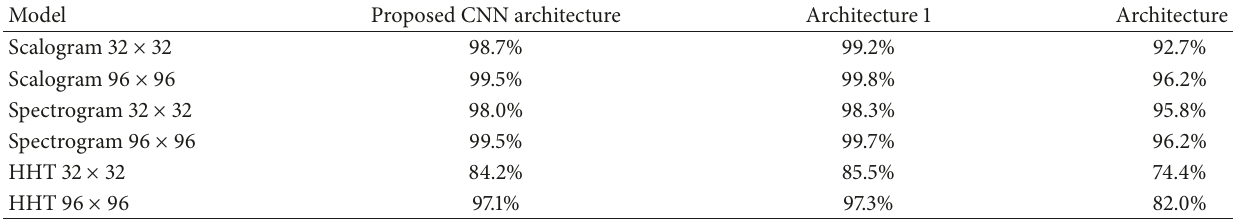
Table 23: Sensitivity for CWR data set.